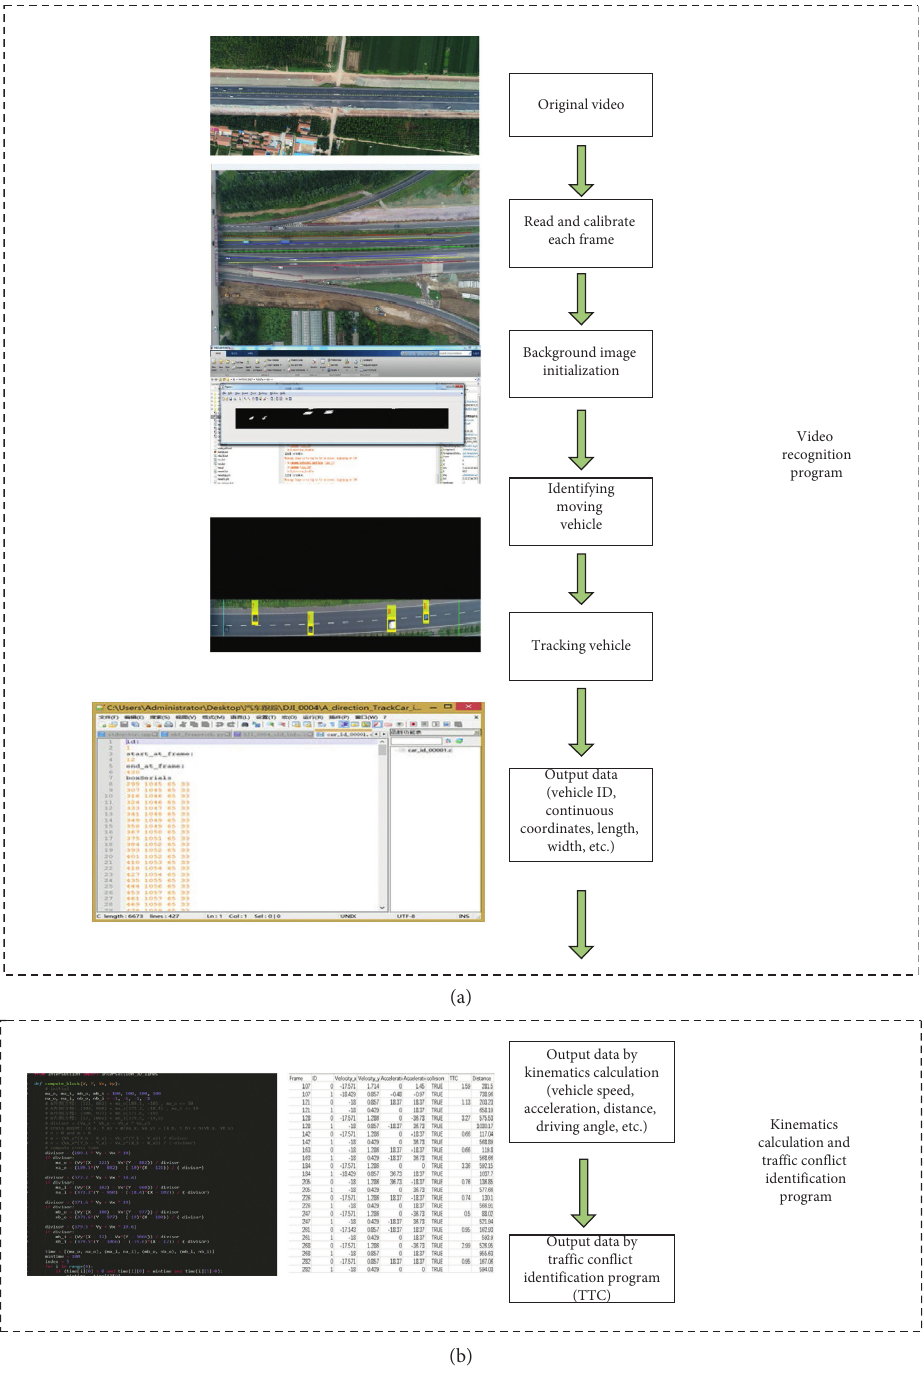
Figure 4: Flow-process diagram of video recognition and traffic conflict